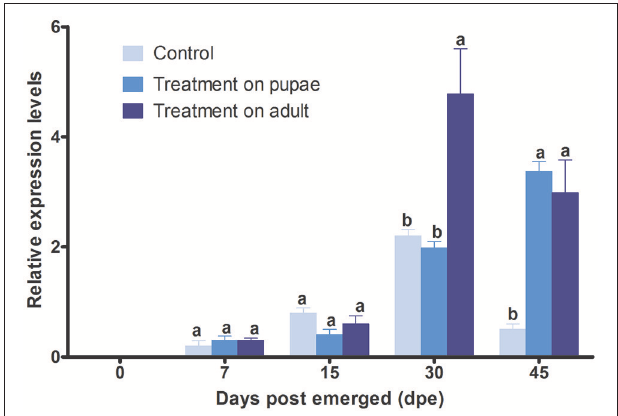
FIGURE 5 | Relative level of expression of B.tauYP gene after irradiation, determined by qRT-PCR. The mRAN level of β -Actin transcript was used to normalize the expression level of candidate gene. We tested for differences in mRNA expression level by using two-way analysis of variance (ANOVA). Each point represents the mean value ± S.E.M of three independent. Different letters indicate significant differences in the level of expression at p < 0.05. Three biological replicates were performed.